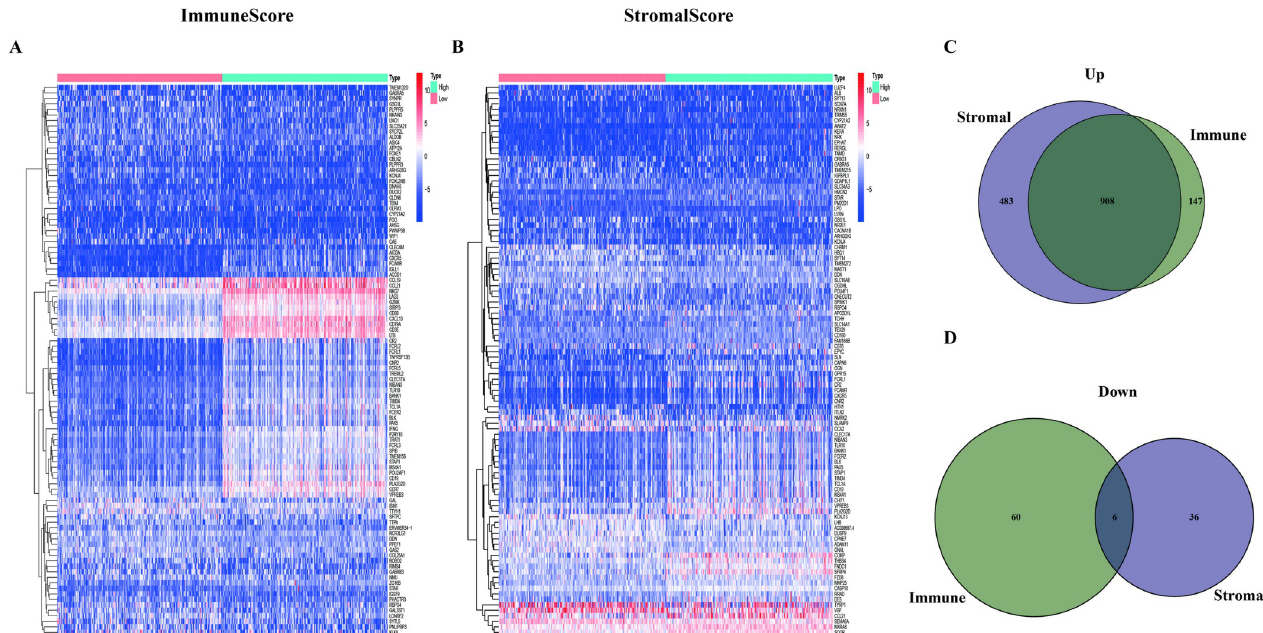
Fig 3. Heatmaps and Venn plots of DEGs. (A) Heatmap of Immune differential genes generated by the comparison between the high Immunescore group and the low Immunescore group. The row name of the heatmap is the name of genes and the column name is sample ID (not added in the figure). (B) Heatmap of Stromal differential genes. (C, D) Venn plots demonstrated the result of the intersection analysis of Immune differential genes and Stromal differential genes.